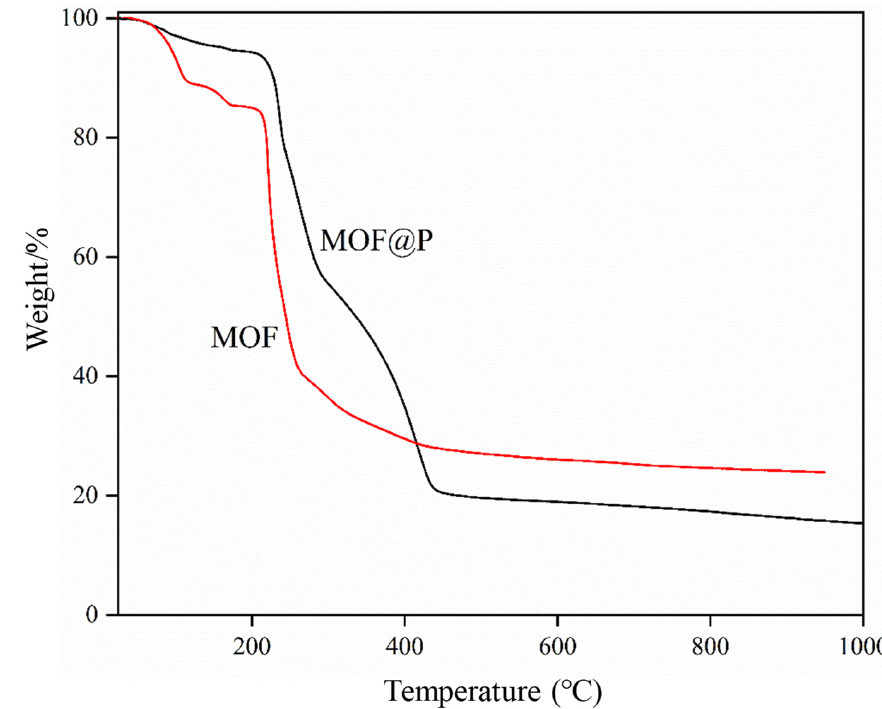
Figure 6. TGA curves of the MOF and MOF@P.